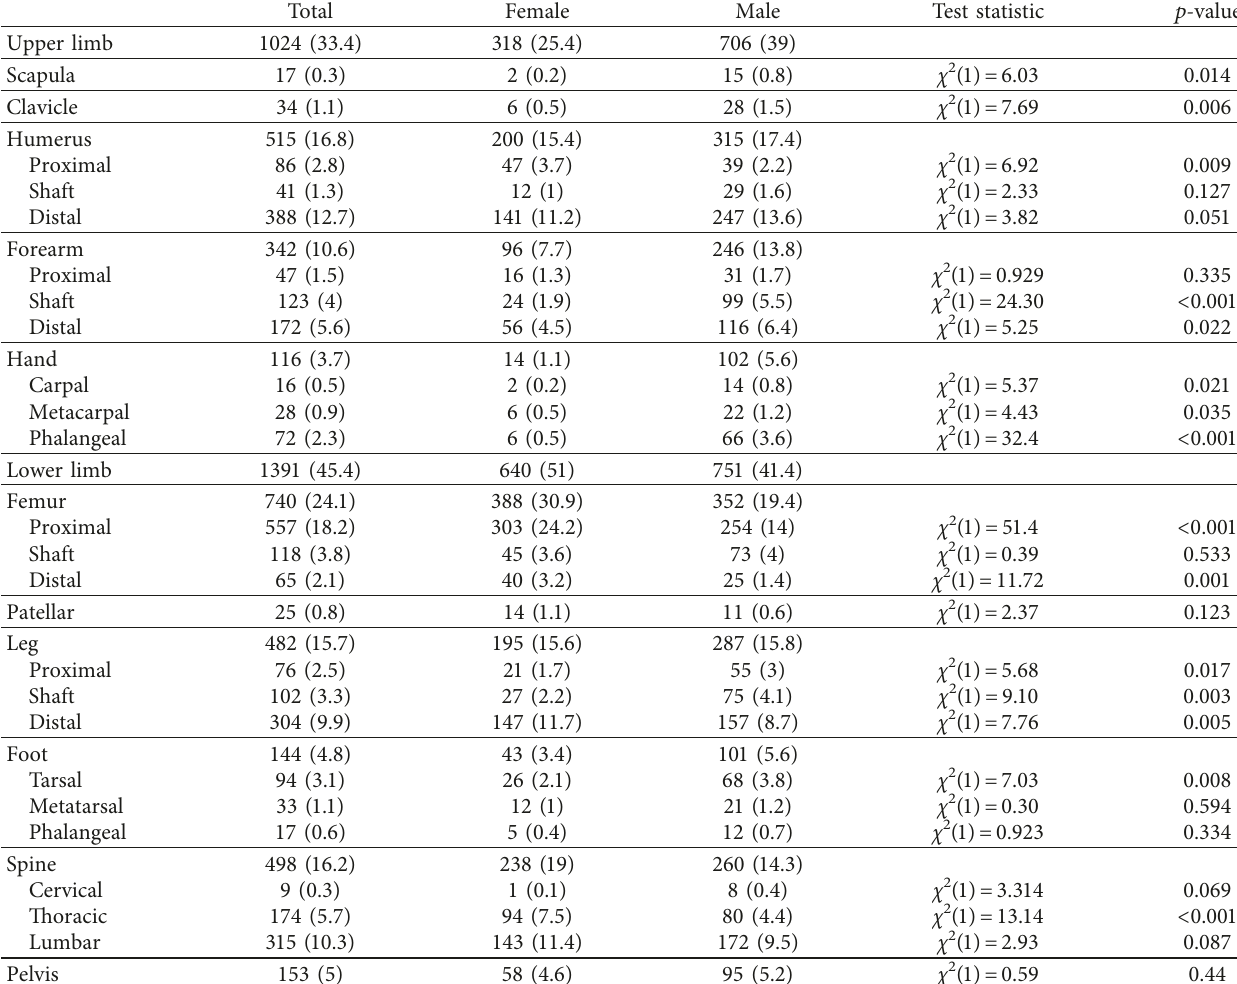
Table 2: Bivariate comparison between male and female bone injury patients.